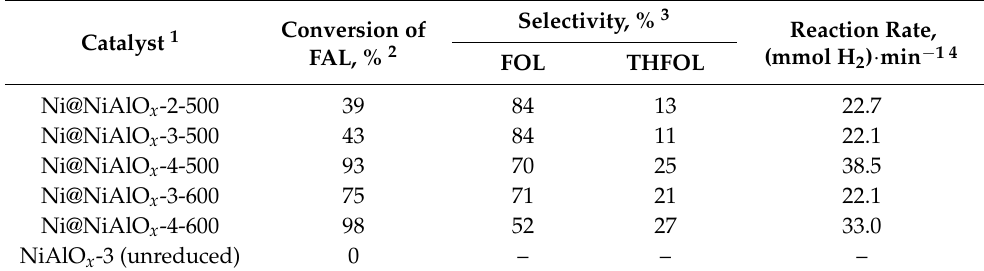
Table 4. Catalytic measurements in hydrogenation of FAL for Ni@NiAlO x samples differing in the Ni/Al atomic ratio and reduction